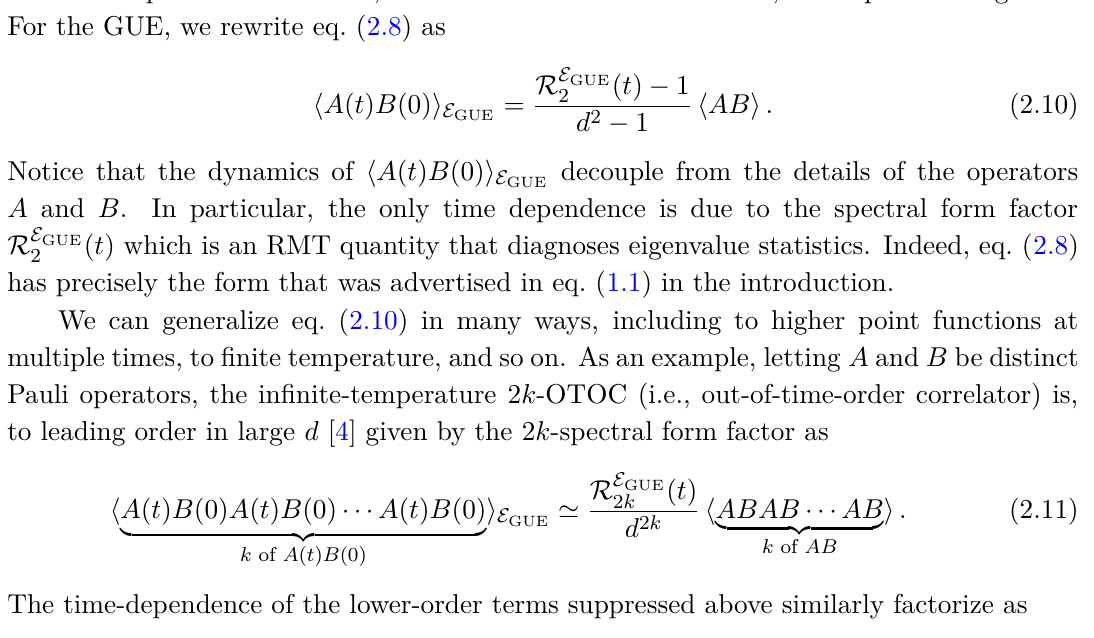
Figure 1 . The spectral form factor R 2 ( t ) for the GUE, depicted on log-log scale. Various features and their corresponding time scales are labelled. The dip time is at ∼ which ends at a time of 2 d and turns into the